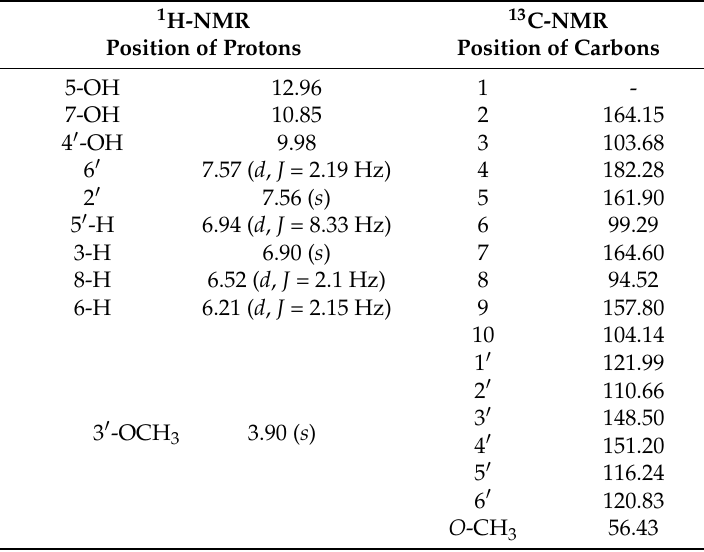
Table 1. 1 H and 13 C-NMR of chrysoeriol (DMSO- d 6 , 900